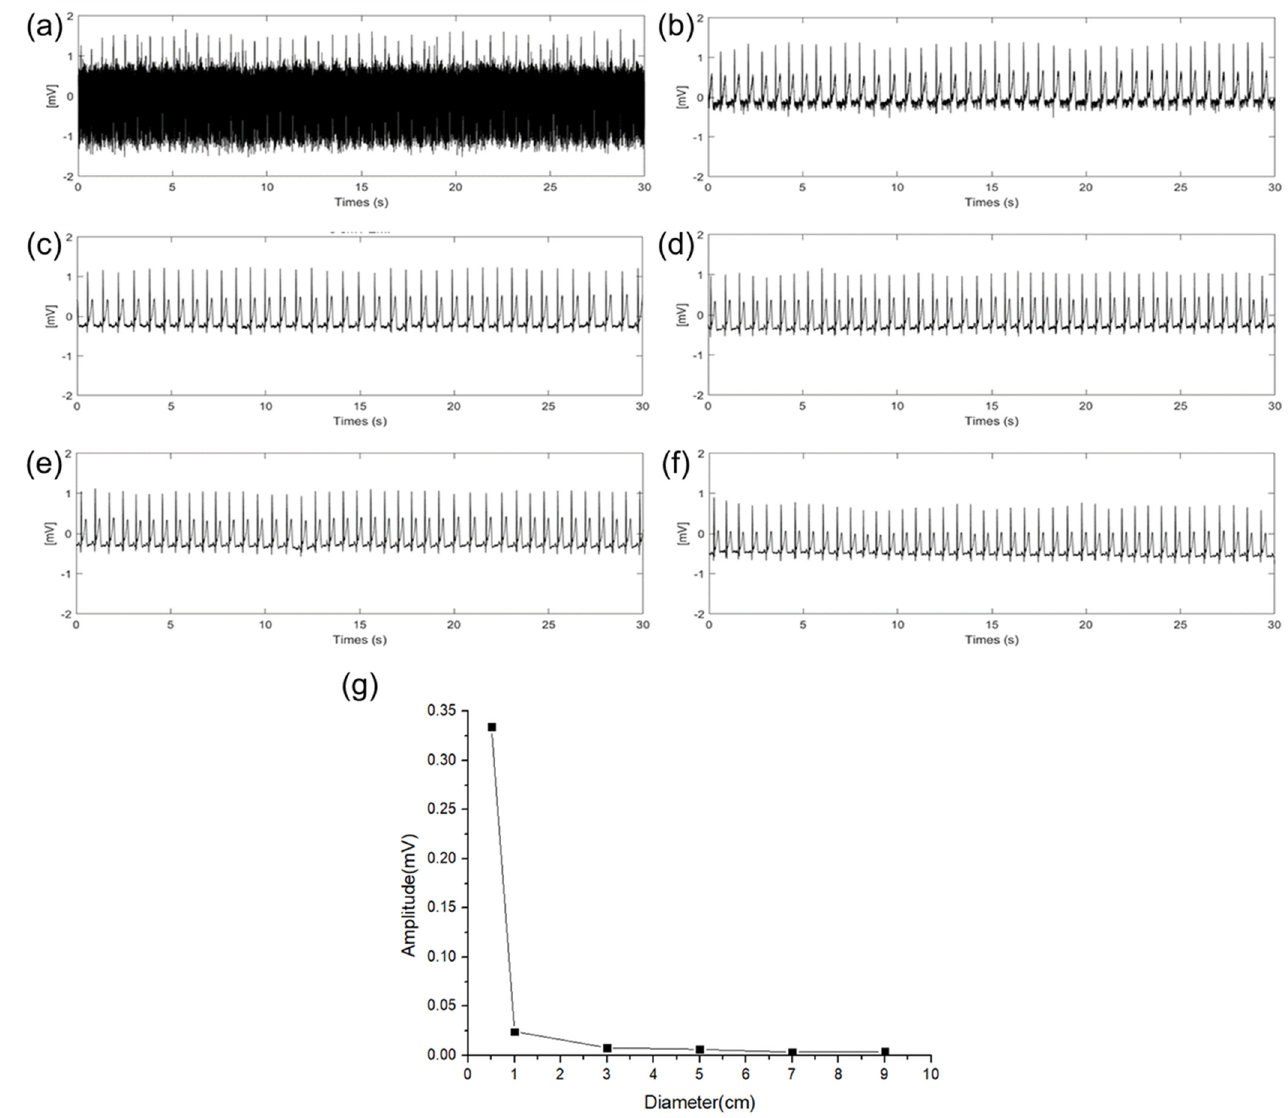
Figure 7. EMI influence according different electrode diameter of ( a ) 0.5 cm, ( b ) 1 cm, ( c ) 3 cm, ( d ) 5 cm, ( e ) 7 cm, ( f ) 9 cm, and ( g ) EMI influence comparison according to the diameter of electrodes.